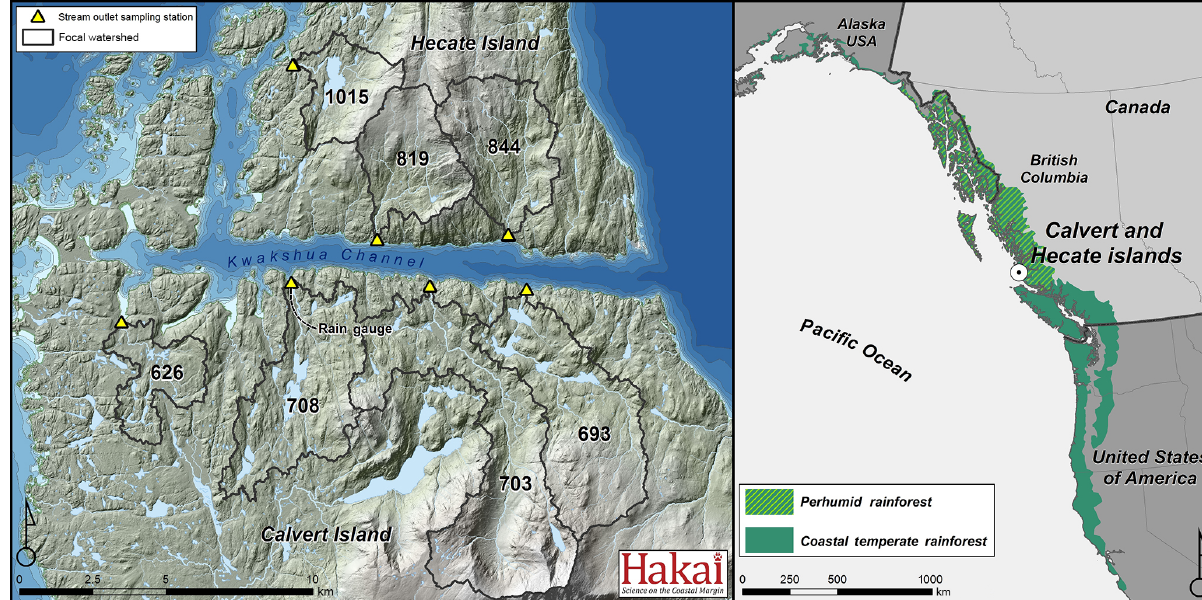
Figure 1. The location of Calvert Island, British Columbia, Canada, within the perhumid region of the coastal temperate rainforest (right) and the study area on Calvert and Hecate islands, including the seven study watersheds, corresponding stream outlet sampling stations, and location of the rain gauge (left). Characteristics of individual watersheds are described in Table